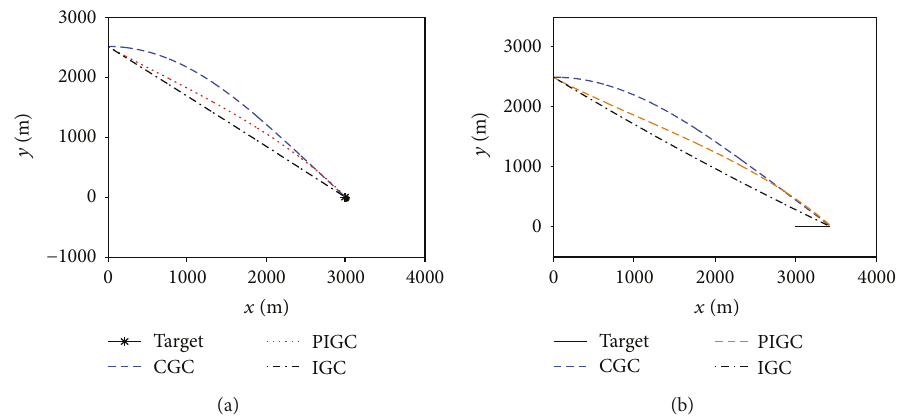
Figure 4: Missile/target trajectories under the three control laws against a fi xed target and a moving target.